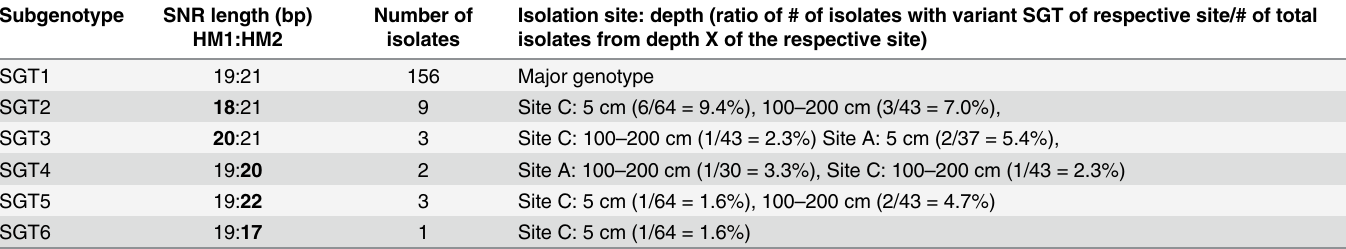
Table 5. SNR sub-genotypes according to length differences in markers HM1 and HM2.